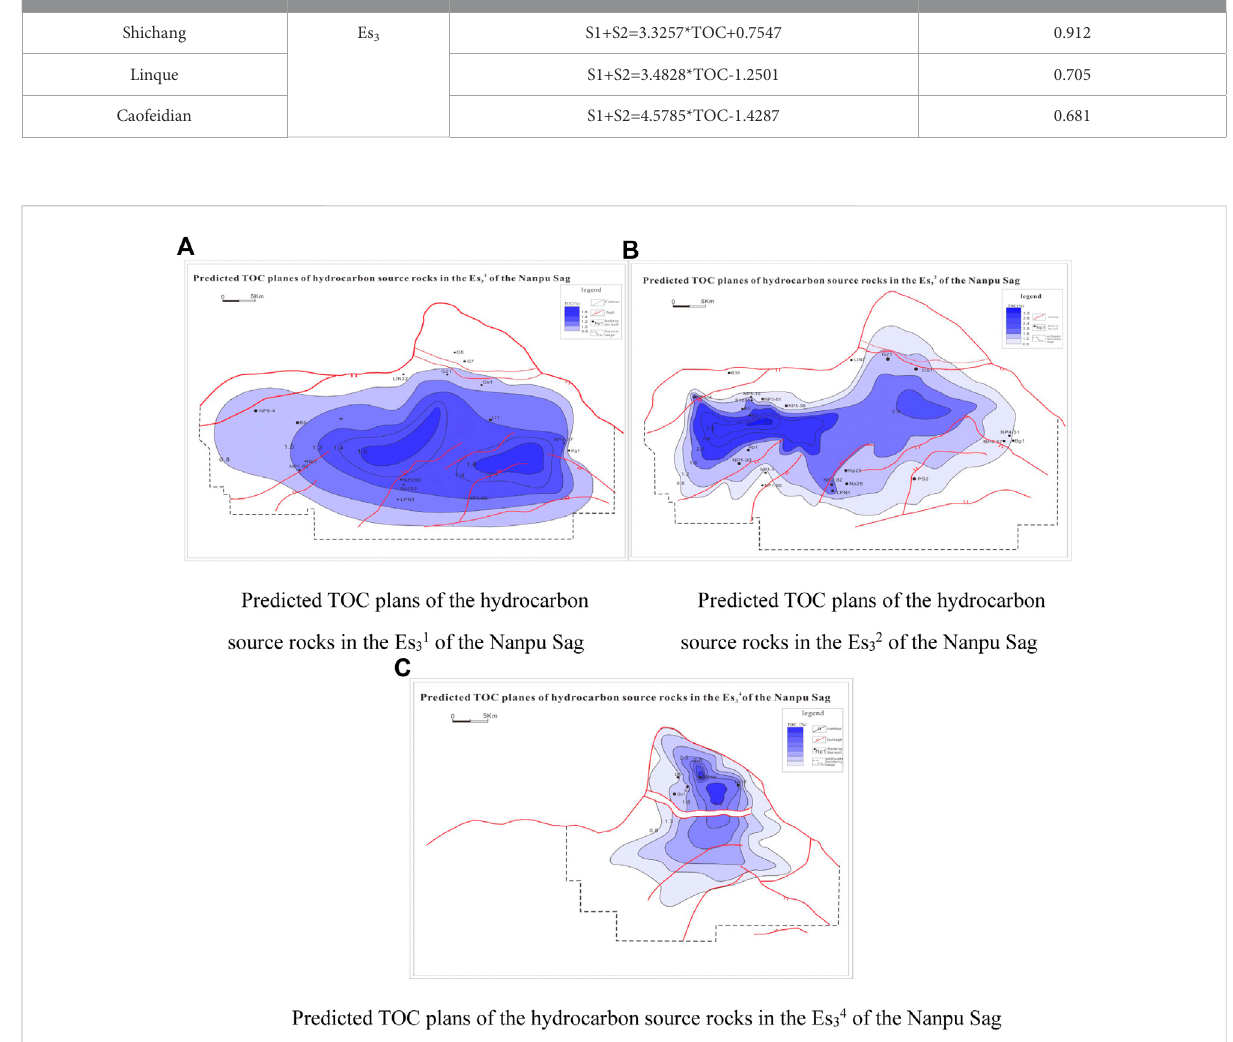
FIGURE 11 TOC planimetry of Es 3 source rocks in different sub depressions of Nanpu Sag. (A) TOC planimetry of the hydrocarbon source rocks in the Es 3 1 subdepression. (B)